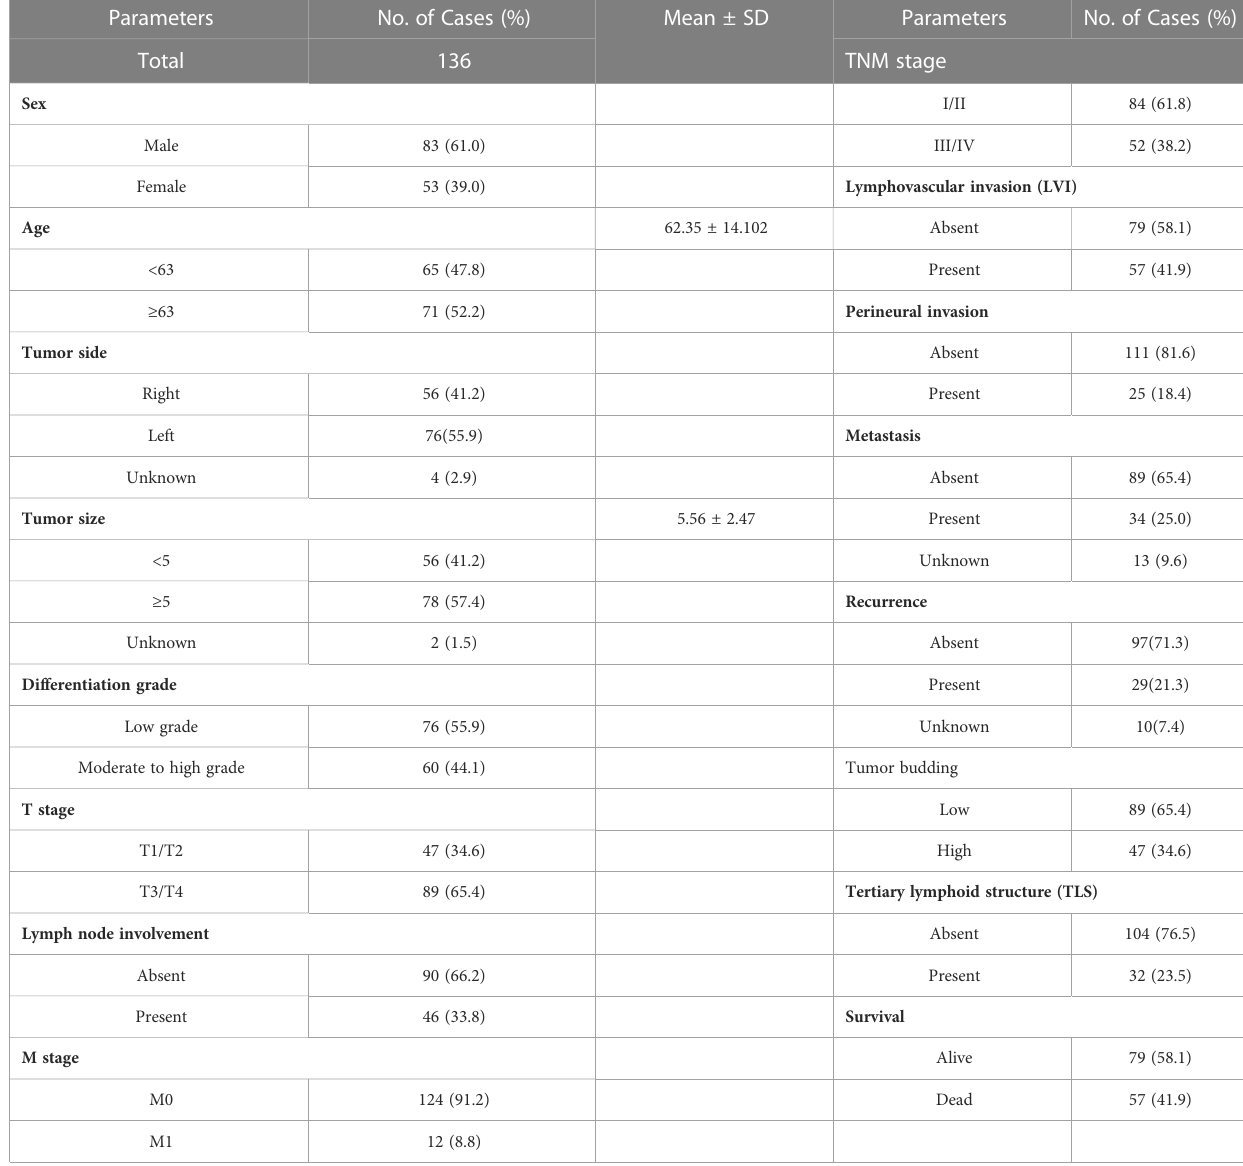
TABLE 1 Demographics characteristics of the